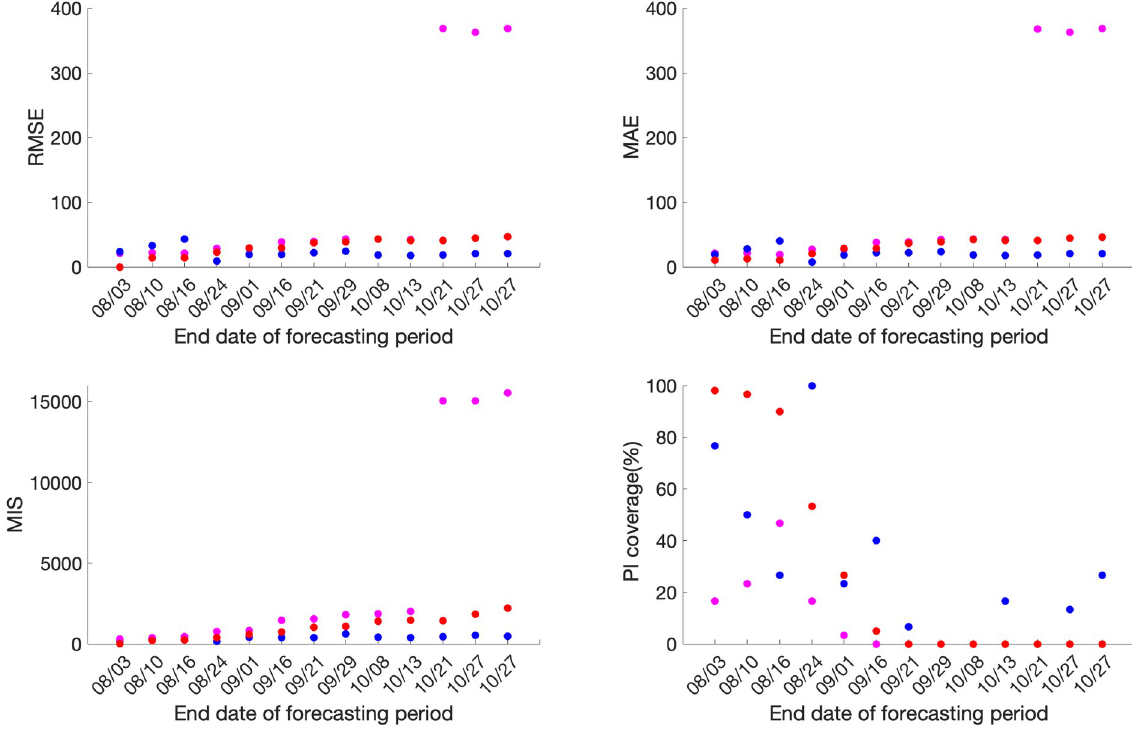
Fig 5. Forecasting period performance metrics for each of the thirteen sequential forecasting phases for GLM (magenta), Richards (red) and sub-epidemic (blue) model for the Mexico City. High 95% PI coverage and lower mean interval score (MIS), root mean square error (RMSE) and mean absolute error (MAE) indicate better